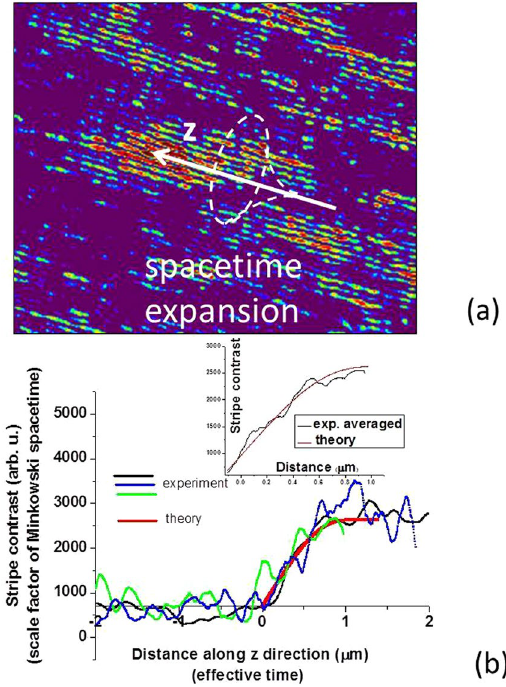
Figure 3. ( a ) Magnified image of one of the Minkowski domains from Fig. 2(c) illustrates inflation-like expansion of the effective spacetime near the domain wall. ( b ) Measured (black) and theoretically calculated (red) dependencies of the spacetime scale factor − ε 2 on the effective time. The calculations are based on analysis of the measured stripe contrast in ( a ). Also shown in blue and green are experimentally measured scale factors for other Minkowski domains from Fig. 2(c). The measured data are compared with theoretical calculations performed at λ = 1.5 μ m based on Eq. (13). The inset shows further improvement of agreement between theory and experiment upon averaging experimental data over multiple